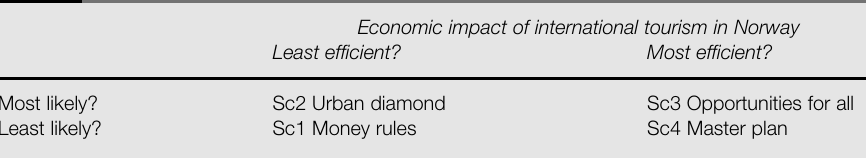
Table II Scenario likelihood and economic